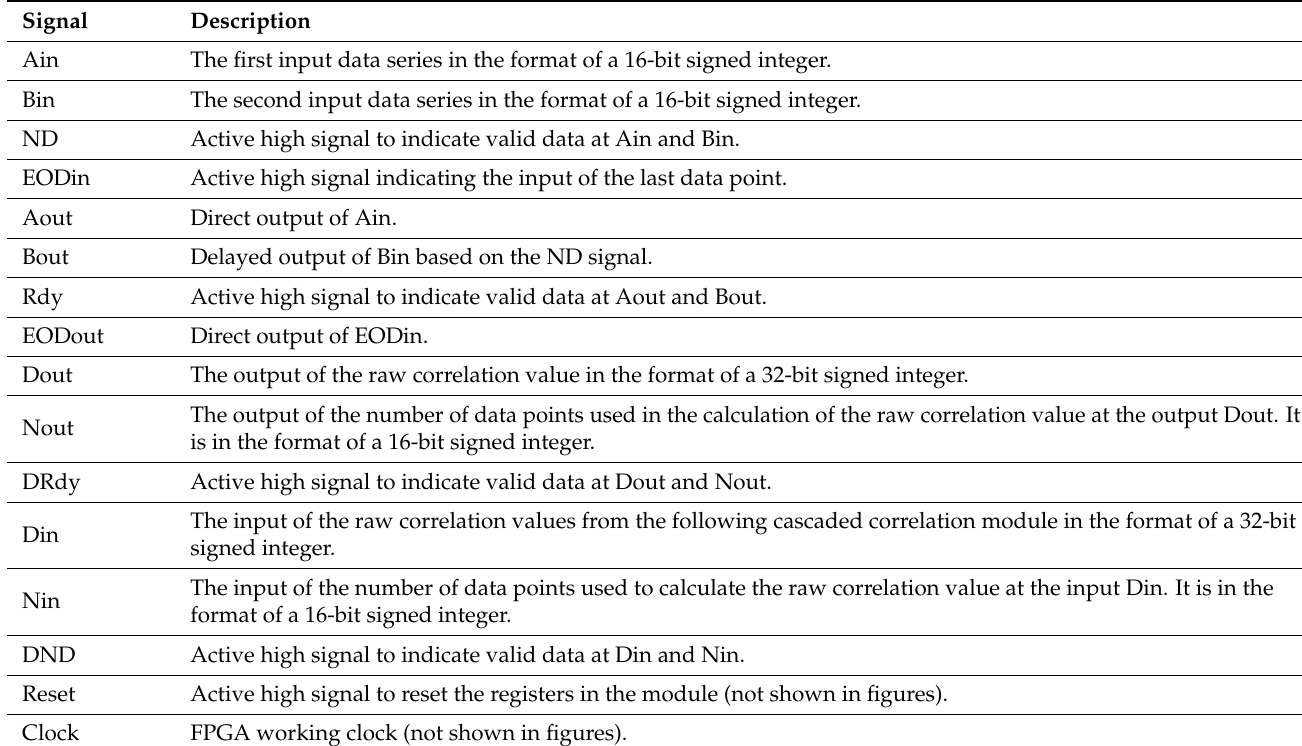
Table 1. Signal definitions of the correlator